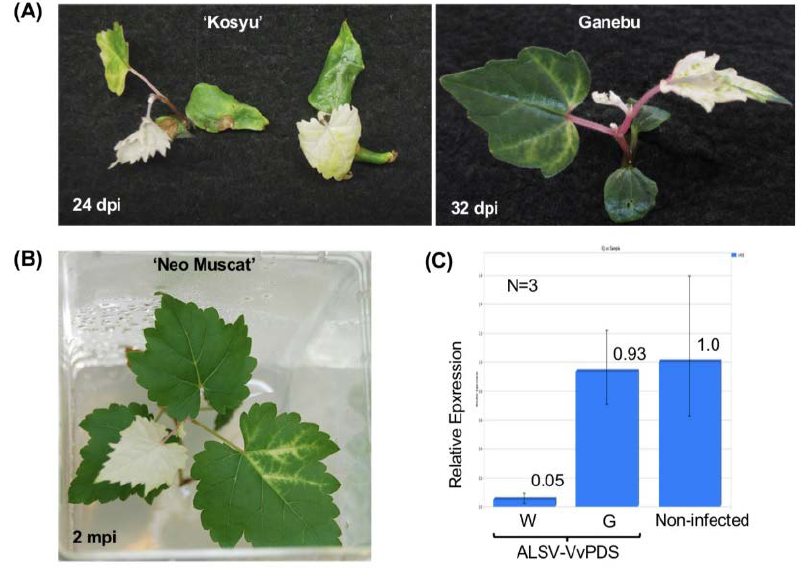
Figure 4. Photo-bleaching phenotype of grapevine seedlings and in vitro cultures inoculated with ALSV-VvPDS. ( A ) ‘Kousyu’ and Ganebu seedlings infected with ALSV-VvPDS at the ‘folded cotyledons’ stage. Dpi; days post inoculation. ( B ) A plantlet from tissue culture (‘Neo Muscat’) inoculated with ALSV-VvPDS at the true leaf stage as shown in Figure 2C (rooted culture) two months after inoculation (mpi). ( C ) A quantitative analysis of VvPDS-mRNA in white (W) and green (G) leaves of plants infected with ALSV-VvPDS as shown in ( B ). Reference gene: VvEF1α.